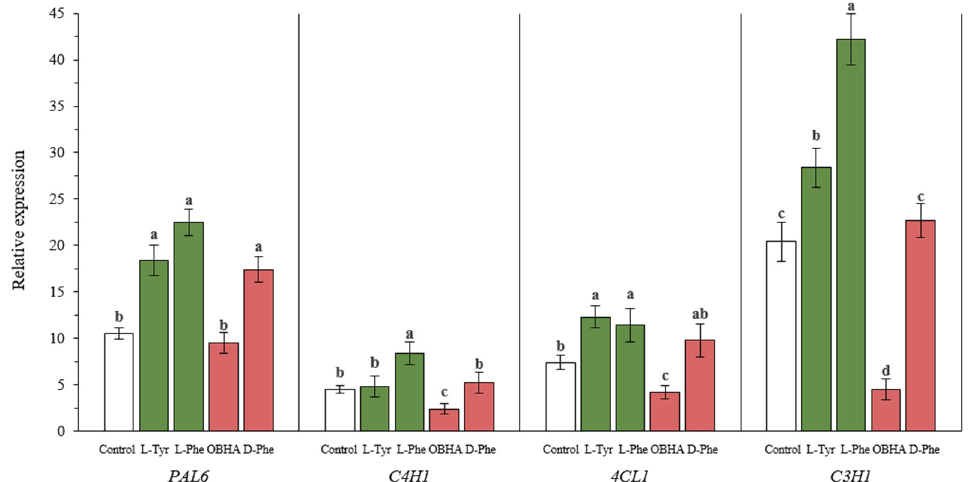
Figure 6. Relative quantitative values of PAL6 , C4H1 , 4CL1 and C3H1 transcripts in wheat plants incubated on a nutrient medium supplemented with 500 µ M of active compounds. Bars marked with different letters show significant differences at ( p ≤ 0.05) according to Tukey’s test.